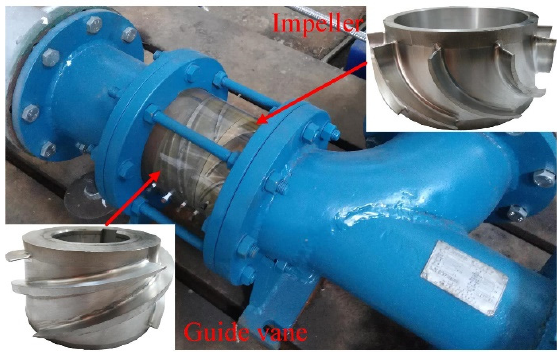
Figure 1. Tested multiphase pump.